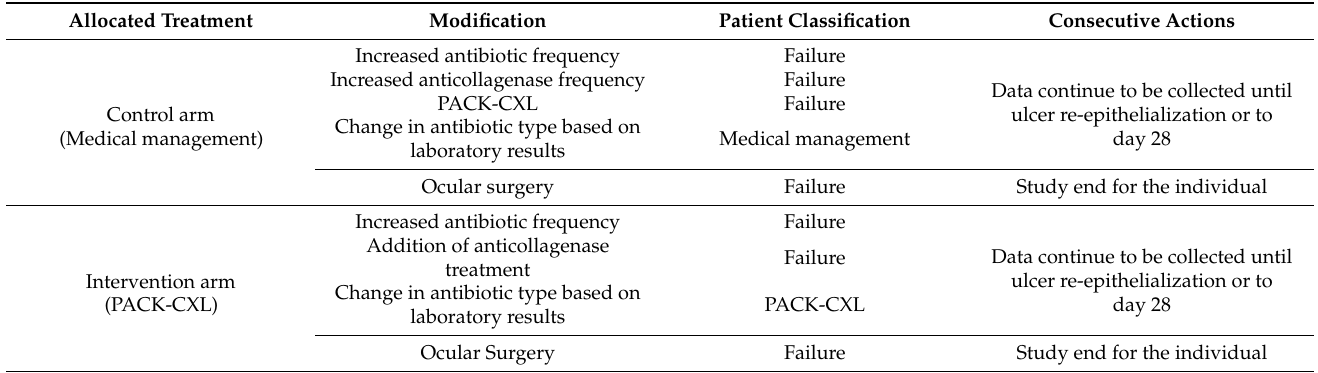
Table 2. Possible modifications to the allocated treatment, consecutive actions, and patient classifica- tion in the